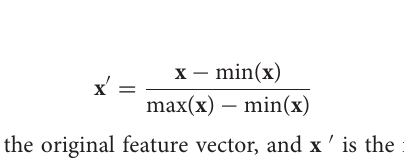
FIGURE 2 | The overall framework of our method: We extracted and selected features according to auditory and visual channels on both databases. Using transfer learning (TL) techniques, we transferred knowledge separately from the MAHNOB-HCI database and employed a feature concatenation method in an attempt to boost performance accuracy in the DEAP dataset ( EEG A , V , EEG auditory or visual data; X A , V , auditory or visual input features; Z A , V , combined auditory or visual